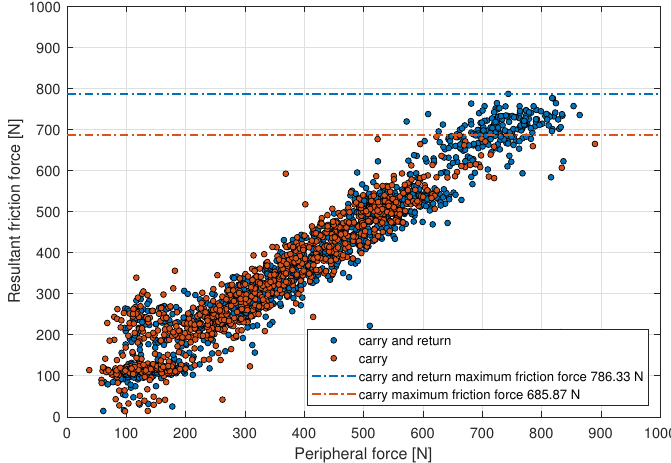
Figure 10. Resultant friction force as a function of intermediate drive peripheral force for two work variants.